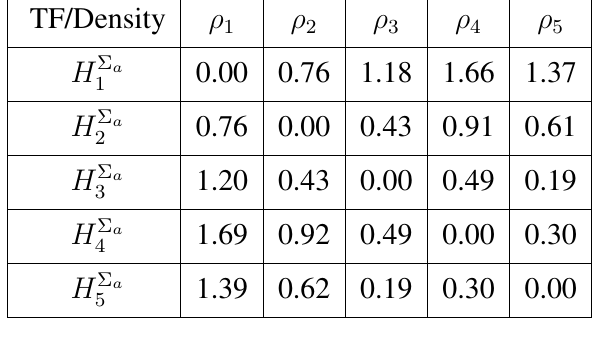
Table 1: MAPE of Σ for different combinations of density profile and transfer functions. a